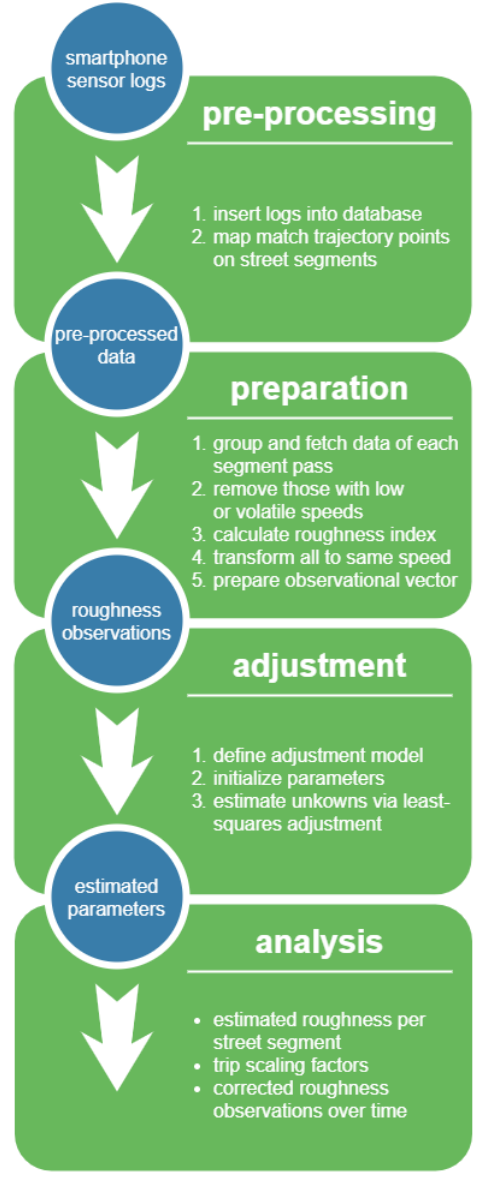
Figure 1. Approach process chain